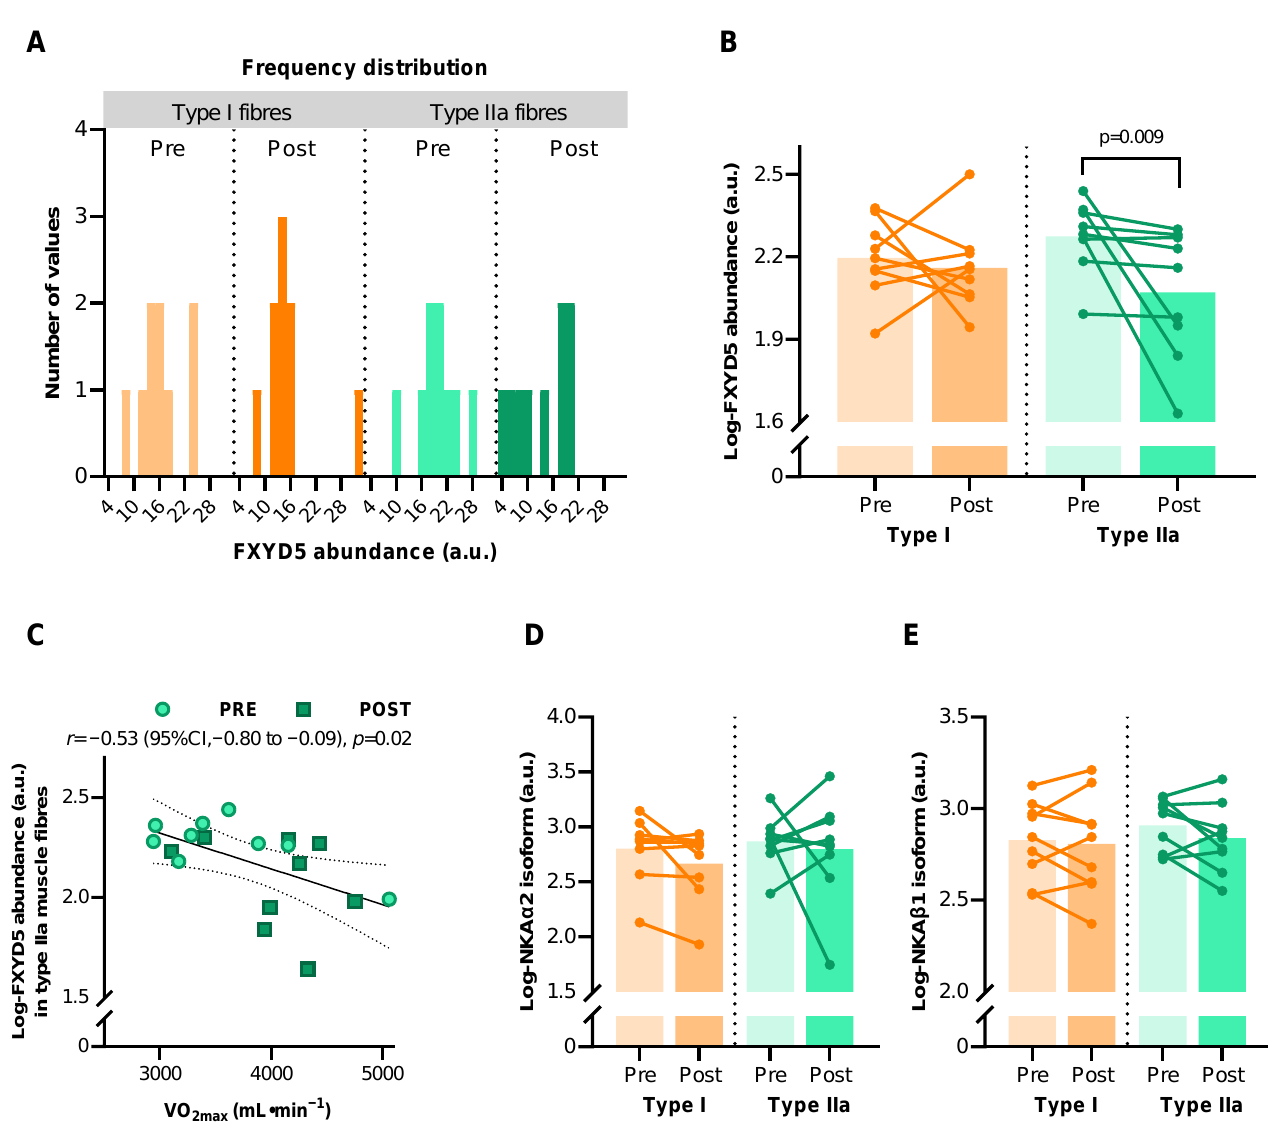
Figure 2. Abundance of Na, K-ATPase (NKA) subunits in human muscle type I and IIa fibre pools before (Pre) and after (Post) 6 weeks of high-intensity interval training (HIIT) 3 times weekly in young males ( n = 8–9). ( A ) Frequency distribution of FXYD5 abundance in human type I and IIa muscle fibres before log-transformation. ( B ) Effect of HIIT on log-FXYD5 abundance. ( C ) Pearson’s correlation between log-FXYD5 abundance and maximal oxygen consumption (VO 2max ). ( D , E ) Effect of HIIT on log-NKA α 2 ( D ) and log-NKA β 1 abundance ( E ). Bars represent mean